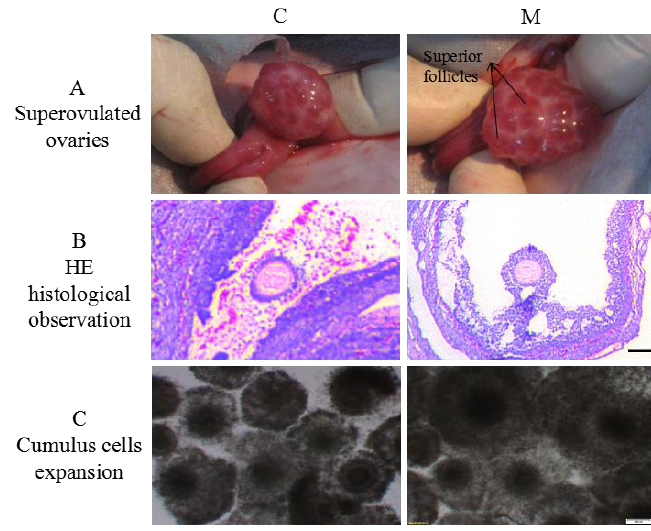
Figure 2. ( A ) Ovaries after superovulation, ( B ) HE histological appearance (bar = 500 μm) and ( C ) expansion of cumulus cell after IVM